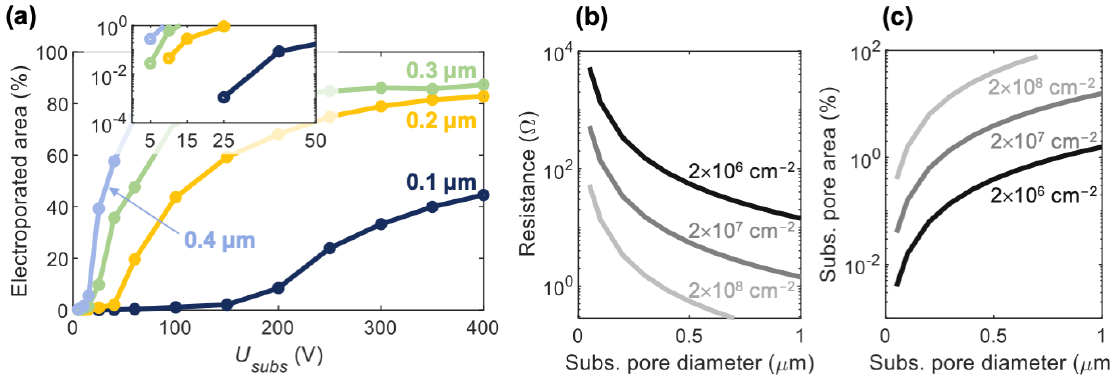
Figure 8. Calculations for substrate pores smaller or equal to 0.4 µm. ( a ) Electroporated fraction of the cell membrane, determined in the same was as in Figure 2d, but for substrate pores with diameters 0.1 µm, 0.2 µm, 0.3 µm, and 0.4 µm (for comparison). Porosity is 2 × 10 6 cm − 2 . The inset shows at which U subs electroporation onsets for each substrate, i.e., at around 25 V, 10 V, 5 V, and 5 V for 0.1 µm, 0.2 µm, 0.3 µm, and 0.4 µm substrate pores, respectively. ( b ) Electrical resistance of substrates with different pore diameters. Results are shown for three different porosities, which cover the range of commercial porous substrates that have been used so far for localized electroporation [21,22]. ( c ) The areal fraction of substrate pores relative to the entire substrate area, depending on pore size and porosity. This areal fraction is directly proportional to the flux of solutes across the substrate.